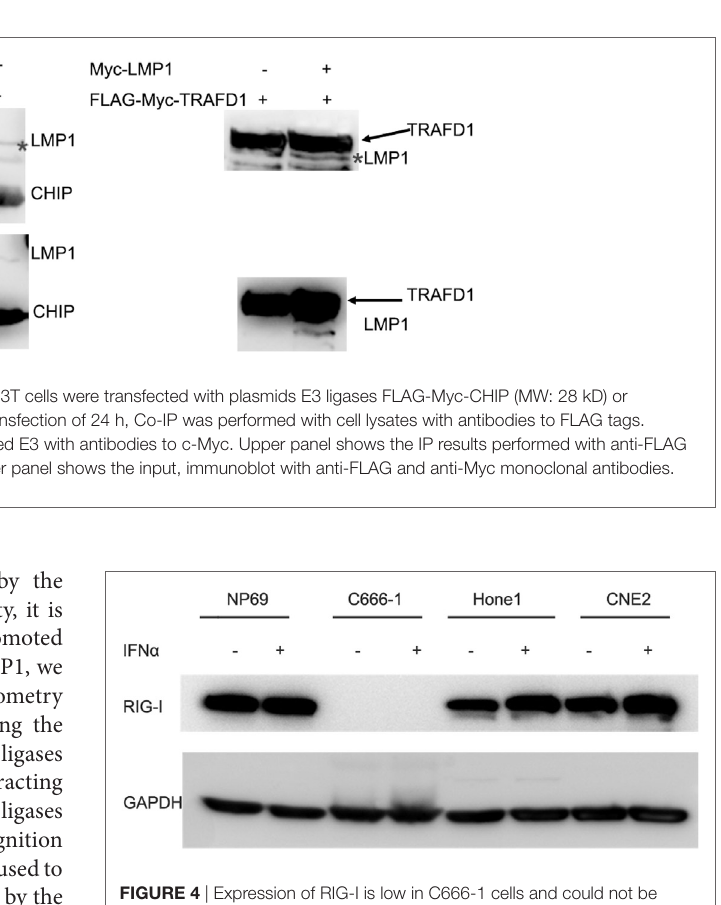
FigUre 4 | Expression of RIG-I is low in C666-1 cells and could not be induced by IFN- α . Nasopharyngeal epithelial cell line NP69 and nasopharyngeal carcinoma cell lines were cultured in the absence or presence of 100 U/ml of IFN- α for 12 h. Expression of RIG-I was determined by Western blot